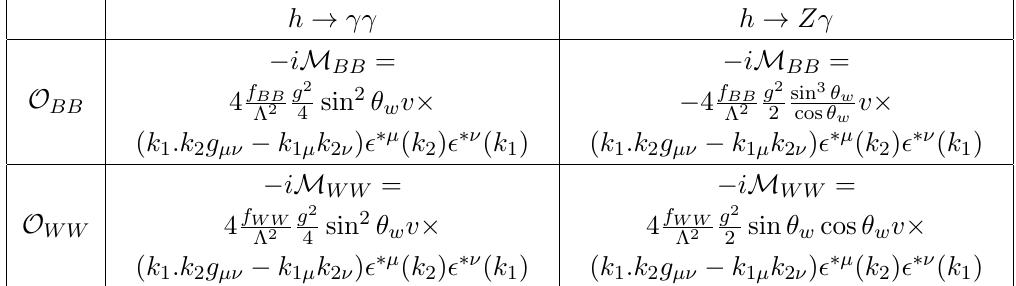
Table 1 . The part of the amplitudes for h ! (cid:13)(cid:13) and h ! Z(cid:13) coming from new particle loops, and expressed in terms of the dimension-6 operators O BB and O WW .